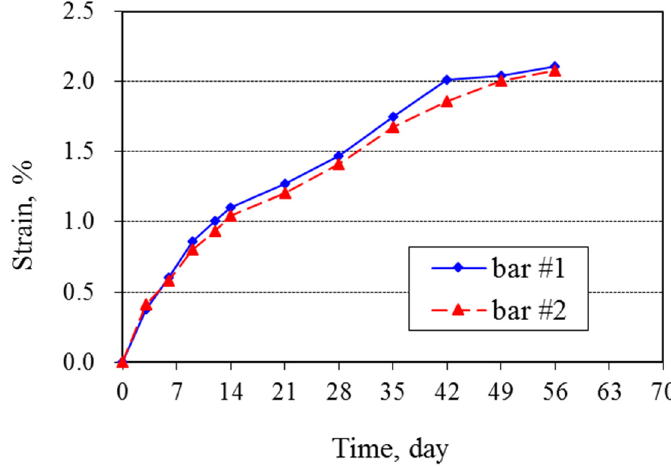
Figure 1. Expansion of mortar bars tested under ASTM C1260.